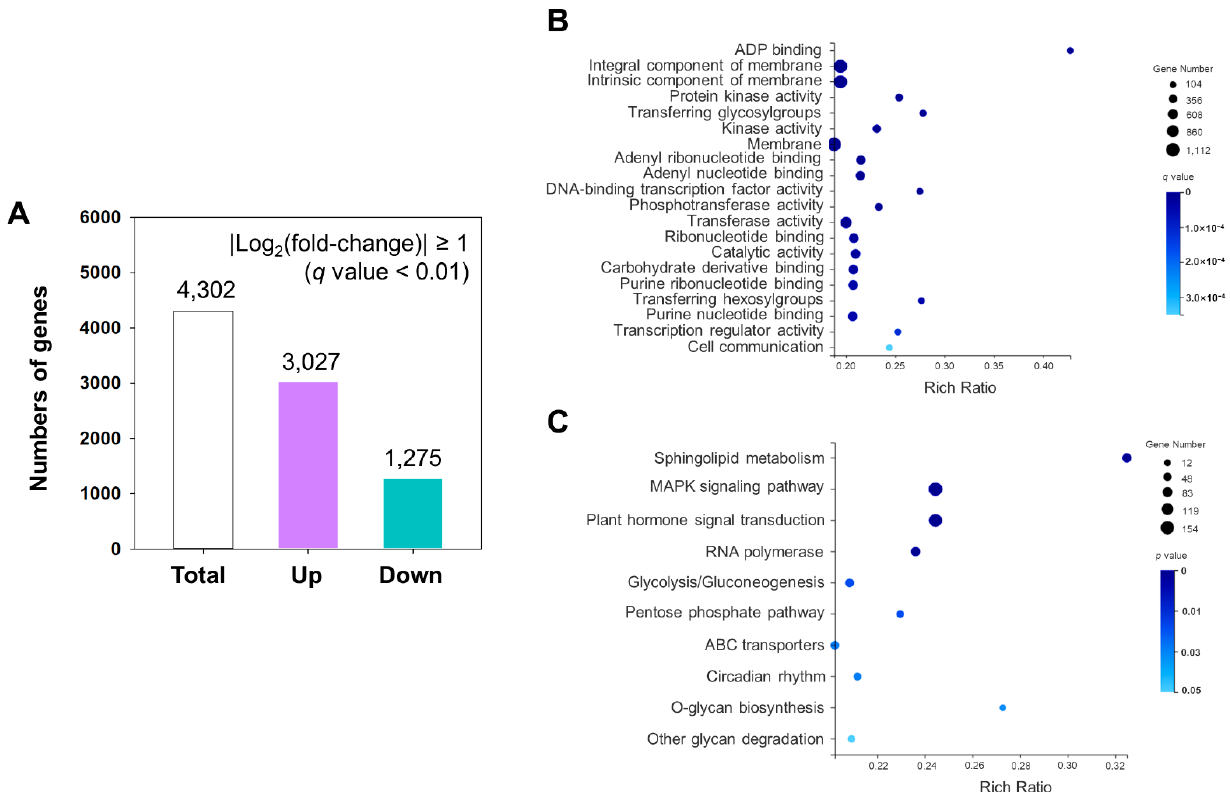
Figure 2. DEGs analysis of D. catenatum response to low temperature. ( A ) Overview of upregulated and downregulated genes in D. catenatum under cold stress. ( B ) GO enrichment analysis of the DEGs. ( C ) KEGG enrichment analysis of DEGs.